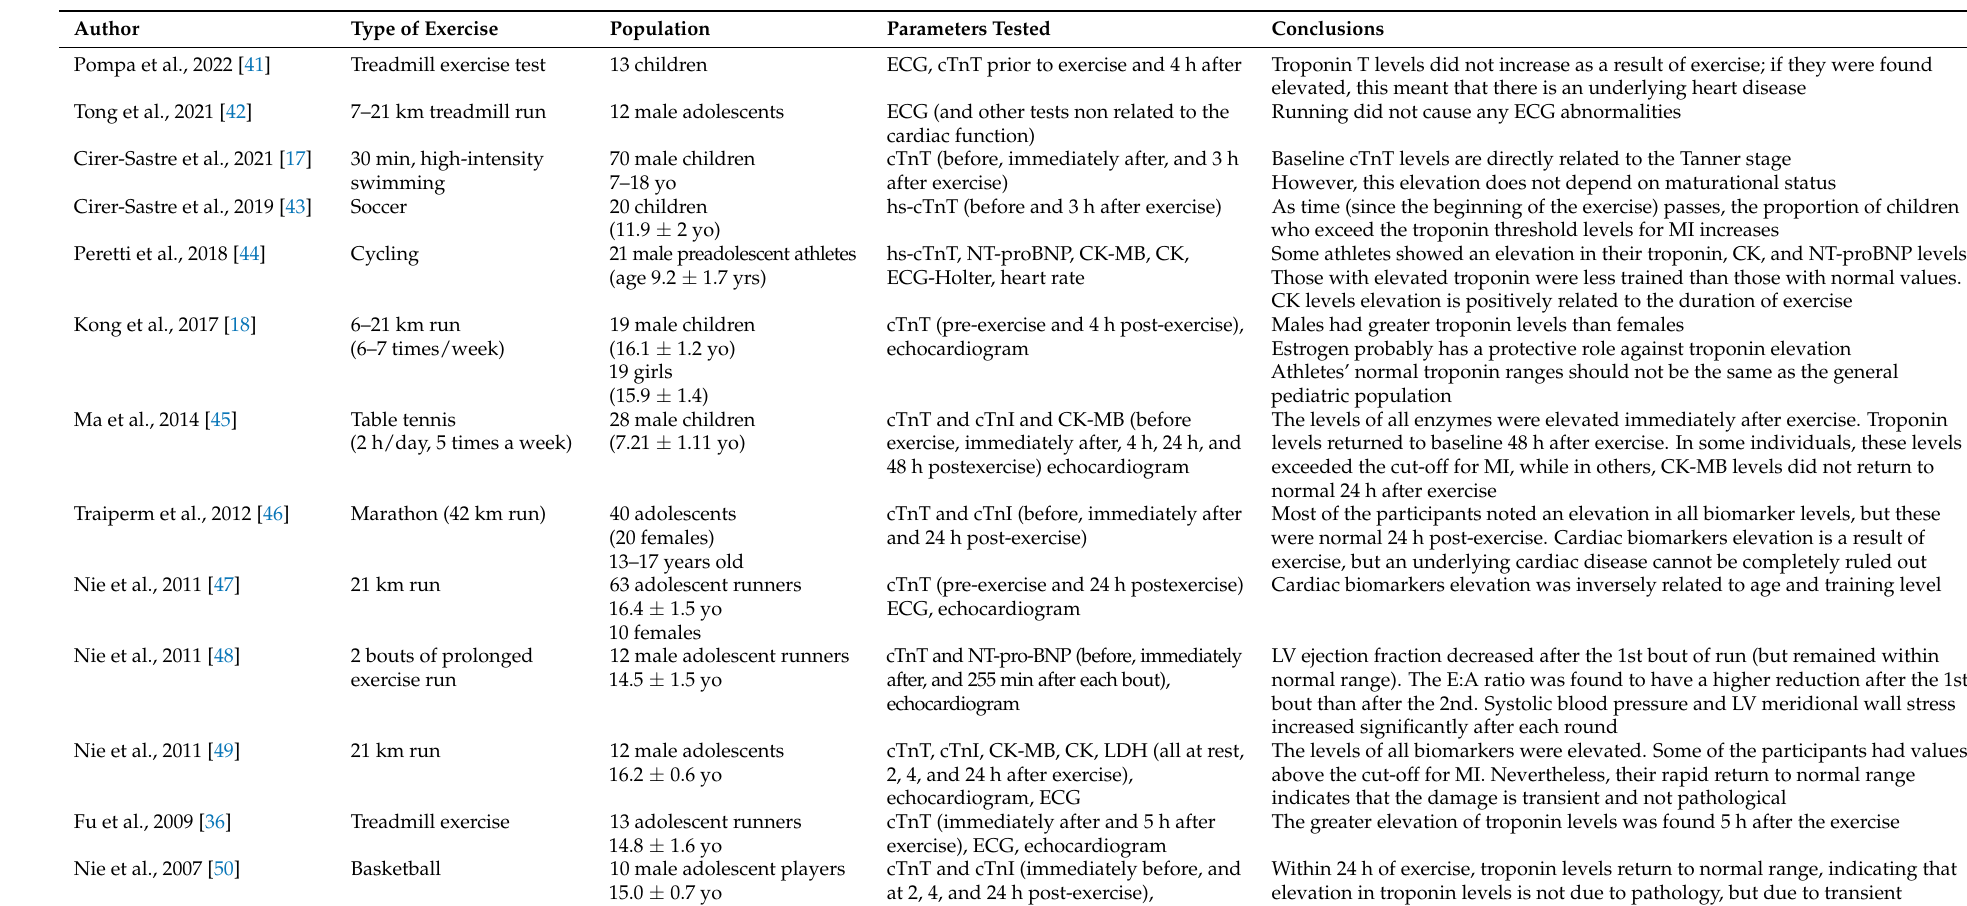
Table 1. Studies reflecting on effects of exercise on cardiac biomarkers in pediatric